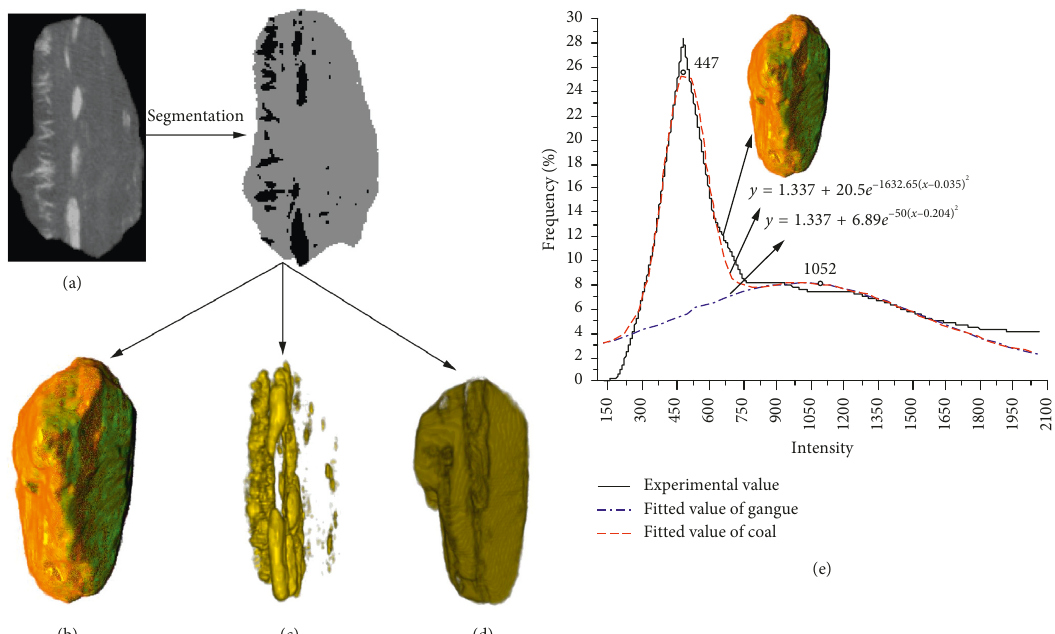
Figure 8: Intensity-frequency distribution curve and 3D volume-rendering image for the selected biphase particle. This figure presents (a) the original CT image; (b) the whole particle; (c) the gangue phase; (d) the coal phase; (e) the frequency distribution curve of